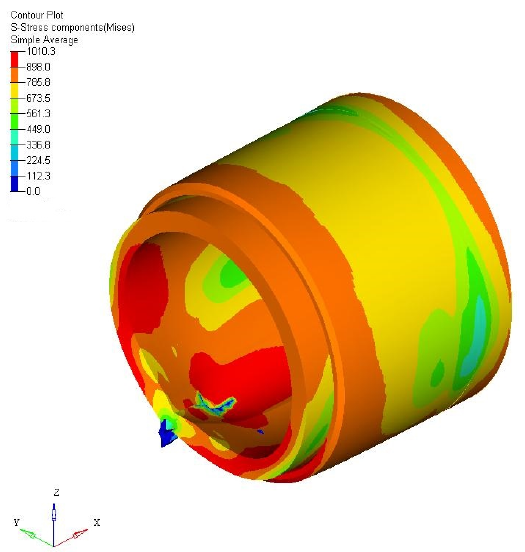
Figure 11. Structural plastic failure occurred in casing connection.